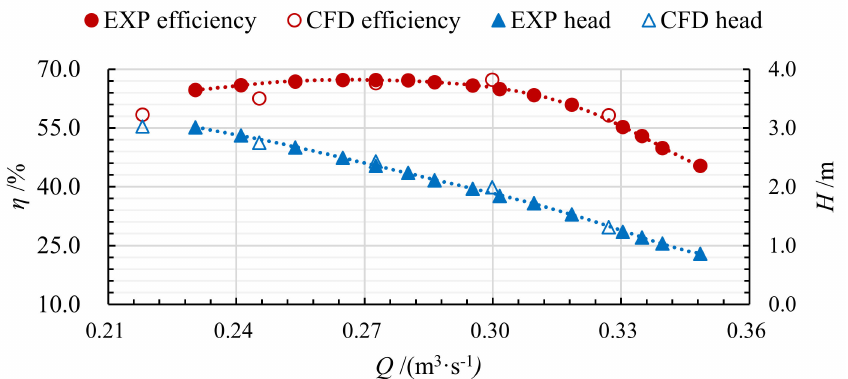
Figure 4. The test bench of full tubular pump device.